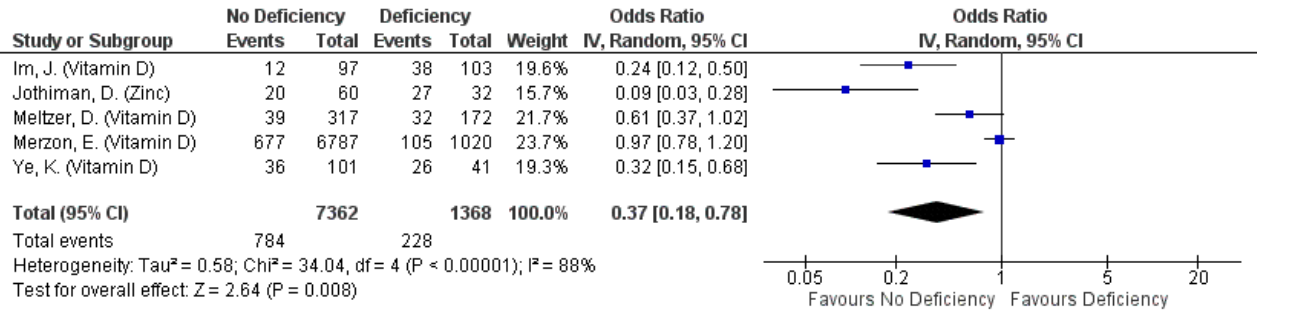
Figure 2. Pooled odds ratio on the incidence of COVID-19 episode when subjects are not deficient, compared to those deficient in any micronutrient singly.